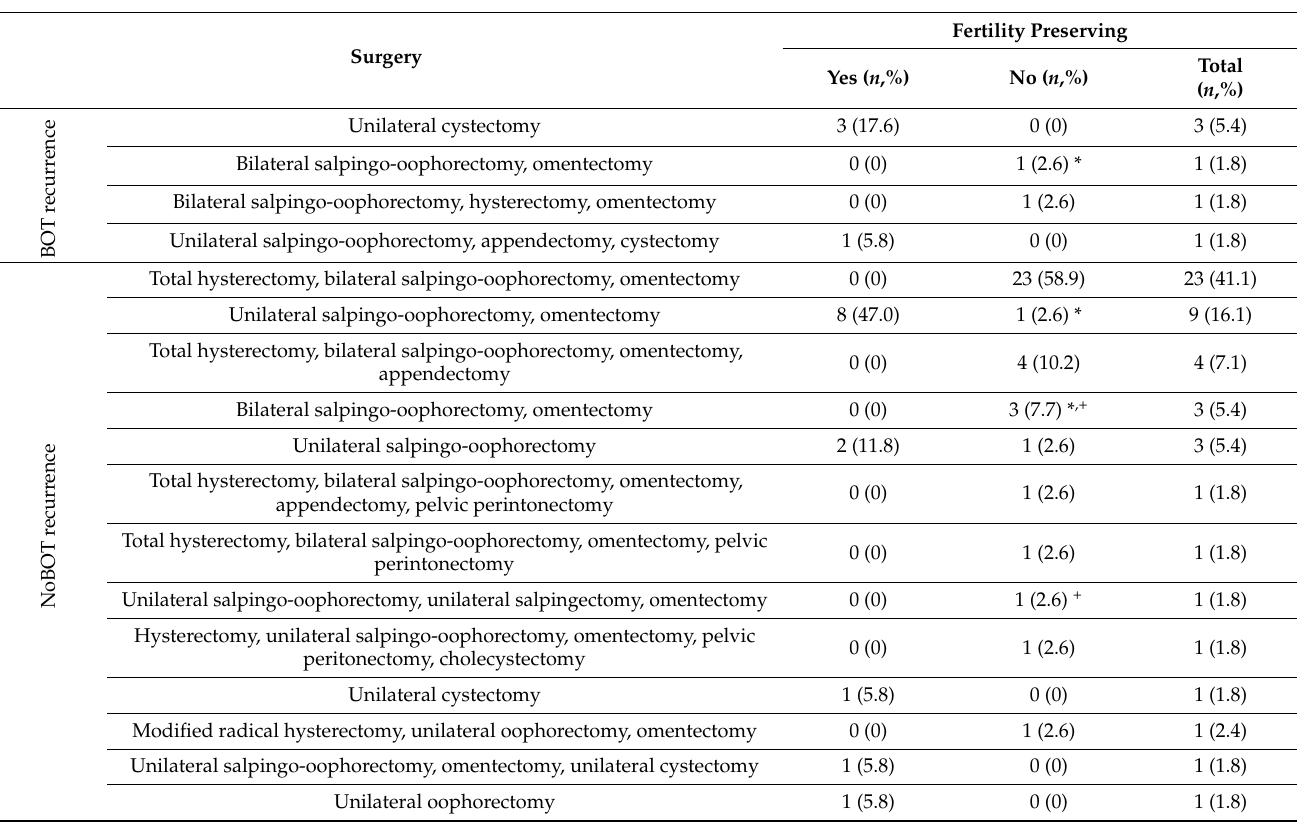
Table 2. Type of surgery each patient